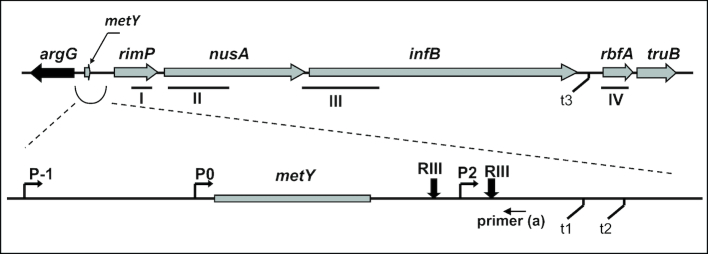
Scheme of the Escherichia coli chromosomal region corresponding to the nusA-infB operon. The region surrounding metY is enlarged to show better the location of the promoters identified so far. The positions of P-1, P0 and P2 promoters, the transcription terminators (t1, t2 and t3) as well as the RNaseIII processing sites are indicated in the scheme. The black arrow indicates the region corresponding to the oligonucleotide primer (a) used in primer extension analyses. The bars designated with roman numbers indicate the sequences corresponding to the probes used for northern blot analyses. Further details are given in the text.